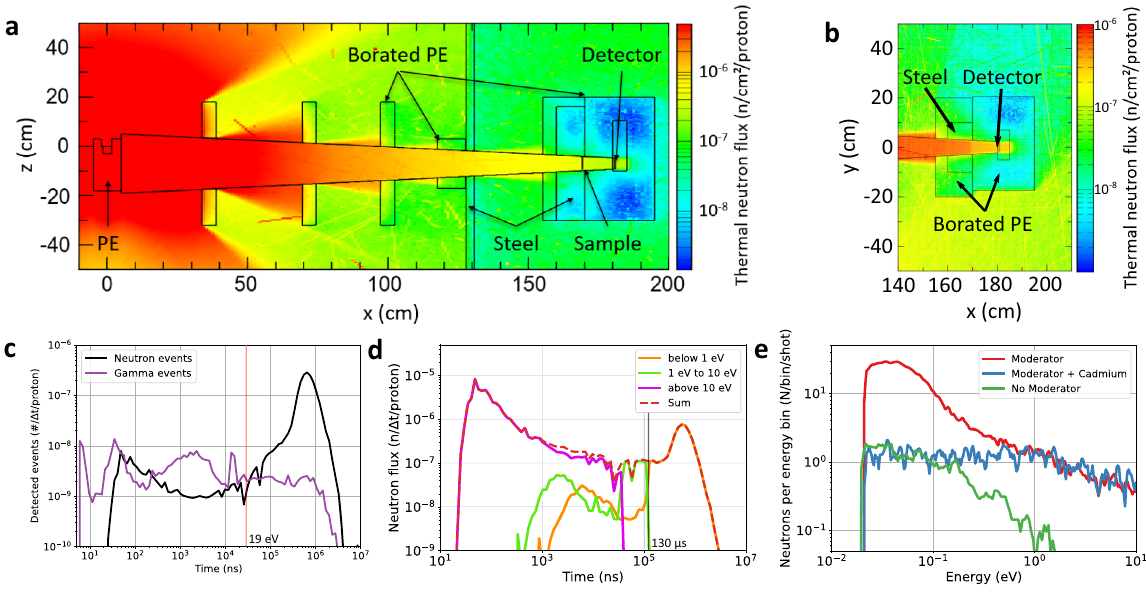
Fig. 3 Optimization of the collimation setup and signal-to-background. a PHITS simulation of the thermal neutron fl ux for the collimation setup (horizontal plane). The converging recess in the collimator parts results in a low background of scattered neutrons at the detector. b PHITS simulation of the thermal neutron fl ux of the detector shielding (vertical plane). A collimated epithermal neutron beam is produced at the detector position with low background. c Simulated arrival time of neutrons and gamma photons at the detector position including detector response. d Simulated arrival time of neutrons at the detector for different energy ranges (magenta: > 10 eV, green: 1 – 10 eV, orange: <1 eV). The time traces of the 1 – 10 eV and < 1 eV neutrons show signals before the corresponding moderator-detector fl ight time of 41 μ s and 130 μ s, respectively, which means that these neutrons do not have their origin in the moderator but in the borated-PE shielding. However, this neutron background is approximately one order of magnitude lower than the neutron signal from the moderator. e Measurement of the thermal neutron spectrum of the LDNS using the borated MCP as a detector. The red curve shows the measured neutron spectrum with a thermalized neutron peak at 25 meV. To assess the background for thermal energies, a 1-mm cadmium plate is used to block thermal neutrons (blue curve). Background for epithermal energies can be determined when the moderator is removed (green